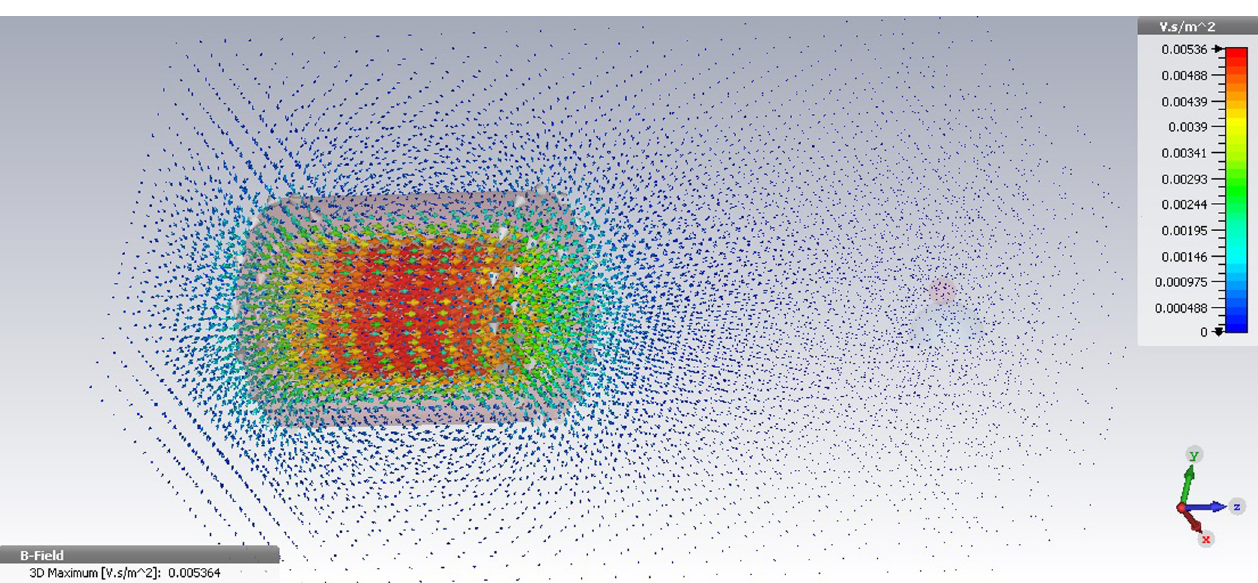
PLOS ONE | https://doi.org/10.1371/journal.pone.0247727 February 25,